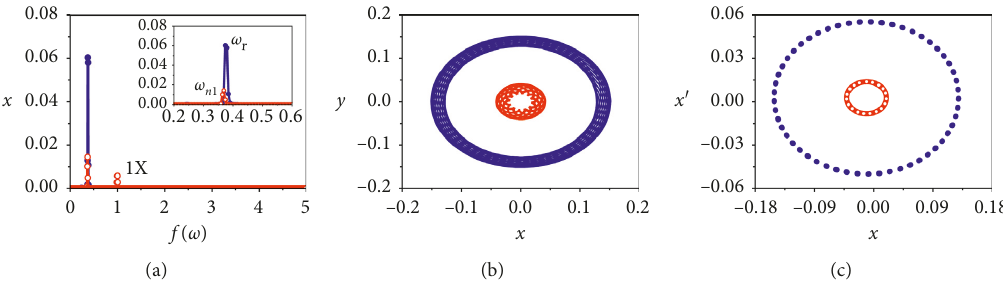
Figure 12: The response of the rotor/seal system with the DVA at s the rotor. (c) The Poincar´e map of the x coordinate.